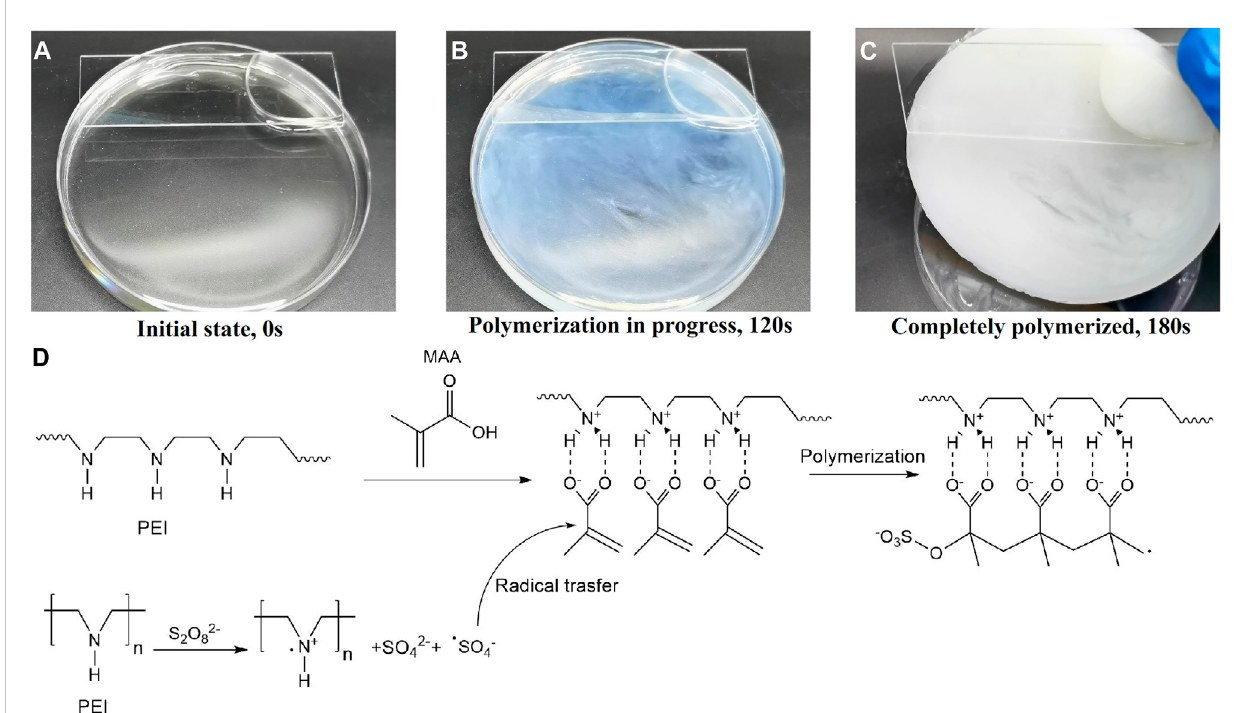
FIGURE 2 ThepolymerizationprocessofPMAA/PEI gel. (A – C) Thephotographofthepolymerizationprogress. (D) Theprincipleofroomtemperaturethermal polymerization.